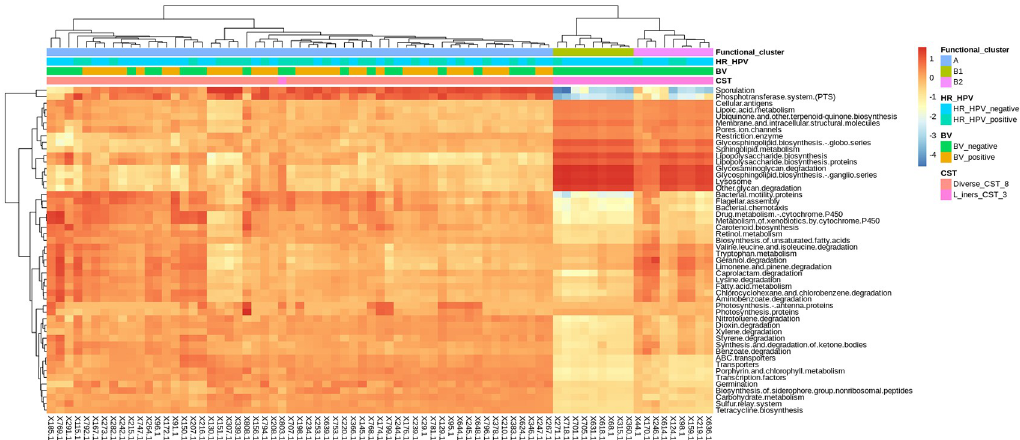
Fig 3. Clustering of the predicted functional categories. The spectral clustering was based on normalized log 2 -transfomred raw count matrix on the predicted functional categories with the greatest variance. The colour key of the log 2 -transformed counts is indicated in the upper right corner. Rows represent the predicted functional categories of the bacterial communities whereas the columns represent the sample identities. Only the top 50 most significant functional modules are shown. Bacterial vaginosis (BV) and high-risk human papillomavirus (HR-HPV) infection status as well as both the taxonomic and functional community state types are indicated beside the colour key. Similar to the taxonomic clusters, two functional clusters (Group-A and Group-B) using were